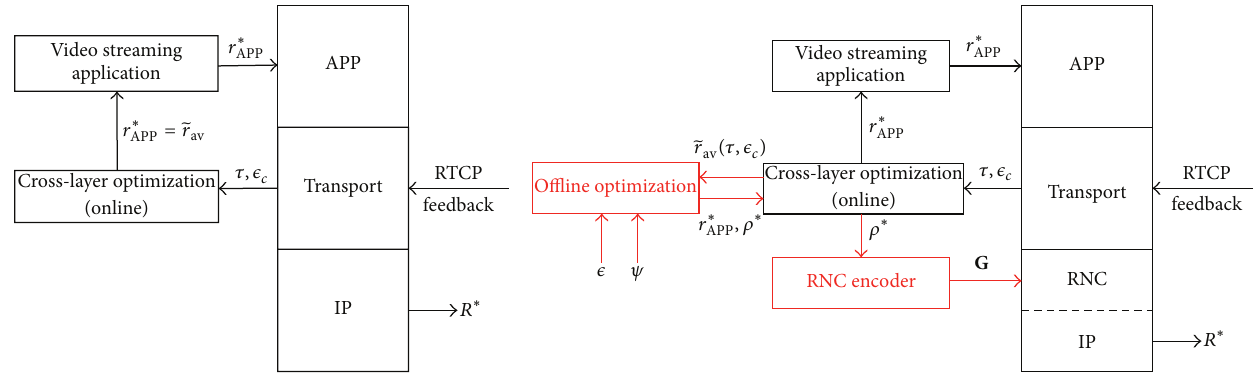
Figure 3: Proposed cross-layer optimization